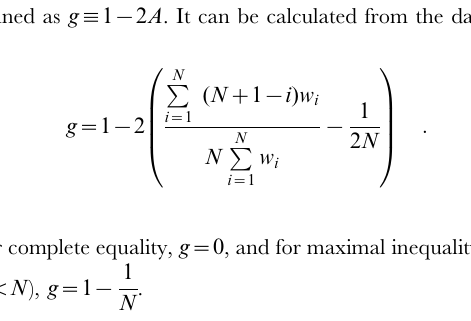
Figure S4 Probability to leave the game as function of age and wealth. Every day except the last, players are sorted into bins according to their current age and their